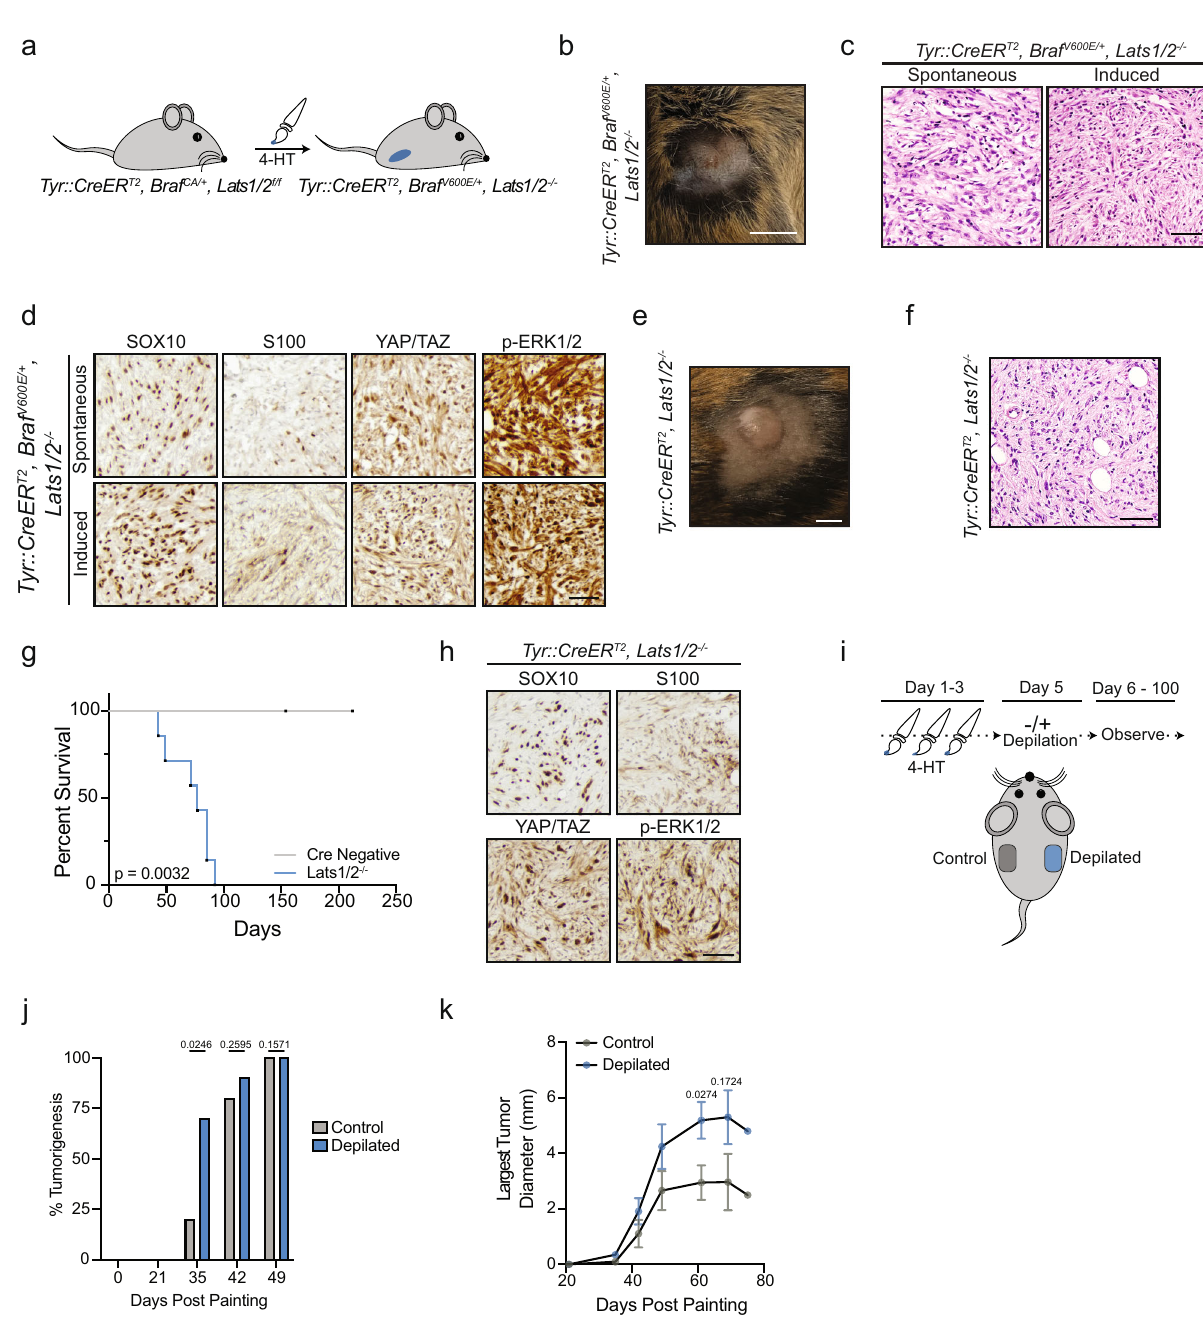
Fig. 5 Lats1/2 deletion promotes melanoma formation. a Cartoondepicting4-HTpaintingexperiment. b Representativeimageofinduced Braf V600E /Lats1/2 − / − mouse tumor, scale bar = 0.5cm. c Representative hematoxylin and eosin staining of spontaneous or induced tumors from Braf V600E /Lats1/2 − / − mice, scale bar = 50 µ m ( n >3 spontaneous tumors, n = 2 induced tumors from Braf V600E /Lats1/2 − / − mice). d Representative IHC of indicated proteins, scale bar = 40 µ m ( n >3 spontaneous tumors, n = 2 induced tumors from Braf V600E /Lats1/2 − / − mice). e Representative image of induced Lats1/2 − / − mouse tumor, scale bar = 0.5cm. f Representative hematoxylin and eosin staining of induced fl ank tumor from Lats1/2 − / − mouse, scale bar = 50 µ m ( n >6 independent mice with similarresults). g Survival plot frompainting tostudy endpoint of Lats1/2 − / − micewith 4-HT painted on fl anks (Crenegative n = 4, Lats1/2 − / − n = 7,log-rank test). h Representative IHC of indicated proteins, scale bar = 40 µ m ( n ≥ 3 Lats1/2 − / − mice). i Cartoon depicting depilation experiment in Lats1/2 − / − mice. j Percent palpable tumorigenesis in Lats1/2 − / − mice at indicated time points ( n = 10 mice, two-tailed unpaired t test). k Diameter of largest tumor on each animal measured at indicated time points ( n ≥ 3 tumors measured at each timepoint with error bars±SEM, ten mice total, two-tailed unpaired t test). Source Data are provided as a Source Data fi